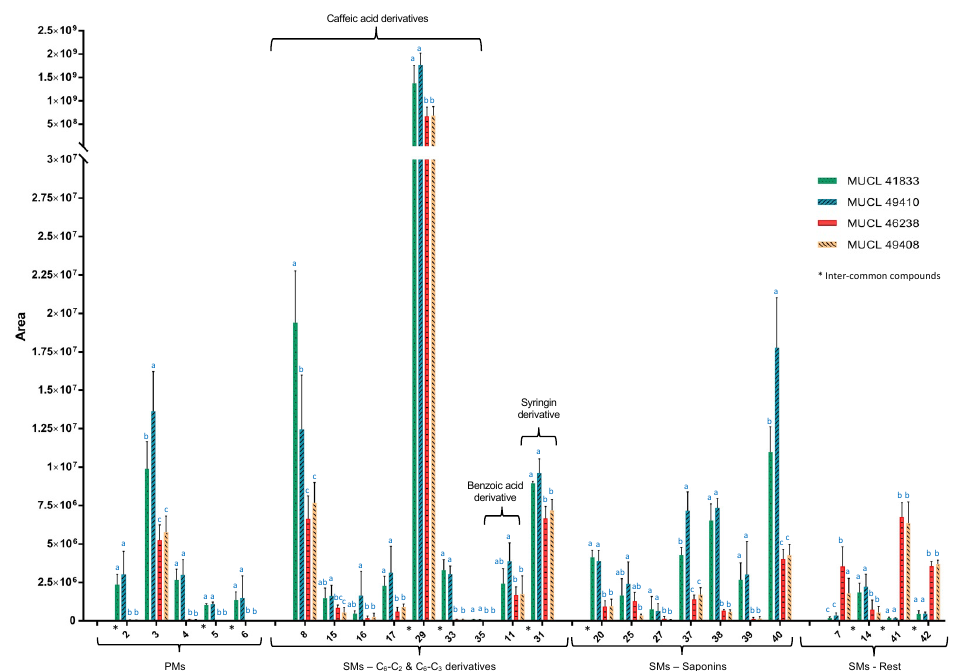
Figure 4. Graphical representation of metabolome profile variations in shoots of Anchusa officinalis associated with four different AMF species ( R. irregularis MUCL 41883, R. intraradices MUCL 49410,